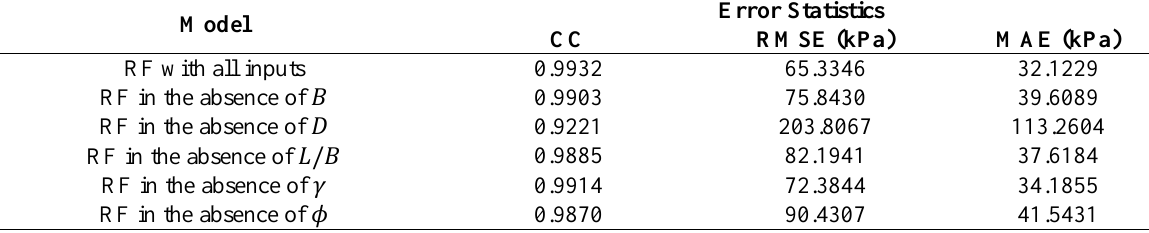
versus for different (The arrow shows the optimal number of grown tree that produced Fig. 3. the least out-of-bag estimate of the error rate) 𝐸𝐸𝐸𝐸𝐸𝐸 𝑂𝑂𝑂𝑂𝑂𝑂 𝑛𝑛𝑡𝑡𝑟𝑟𝑟𝑟𝑟𝑟 𝑚𝑚𝑡𝑡𝑟𝑟𝑚𝑚 Table 4. Sensitivity analysis of the governing parameters